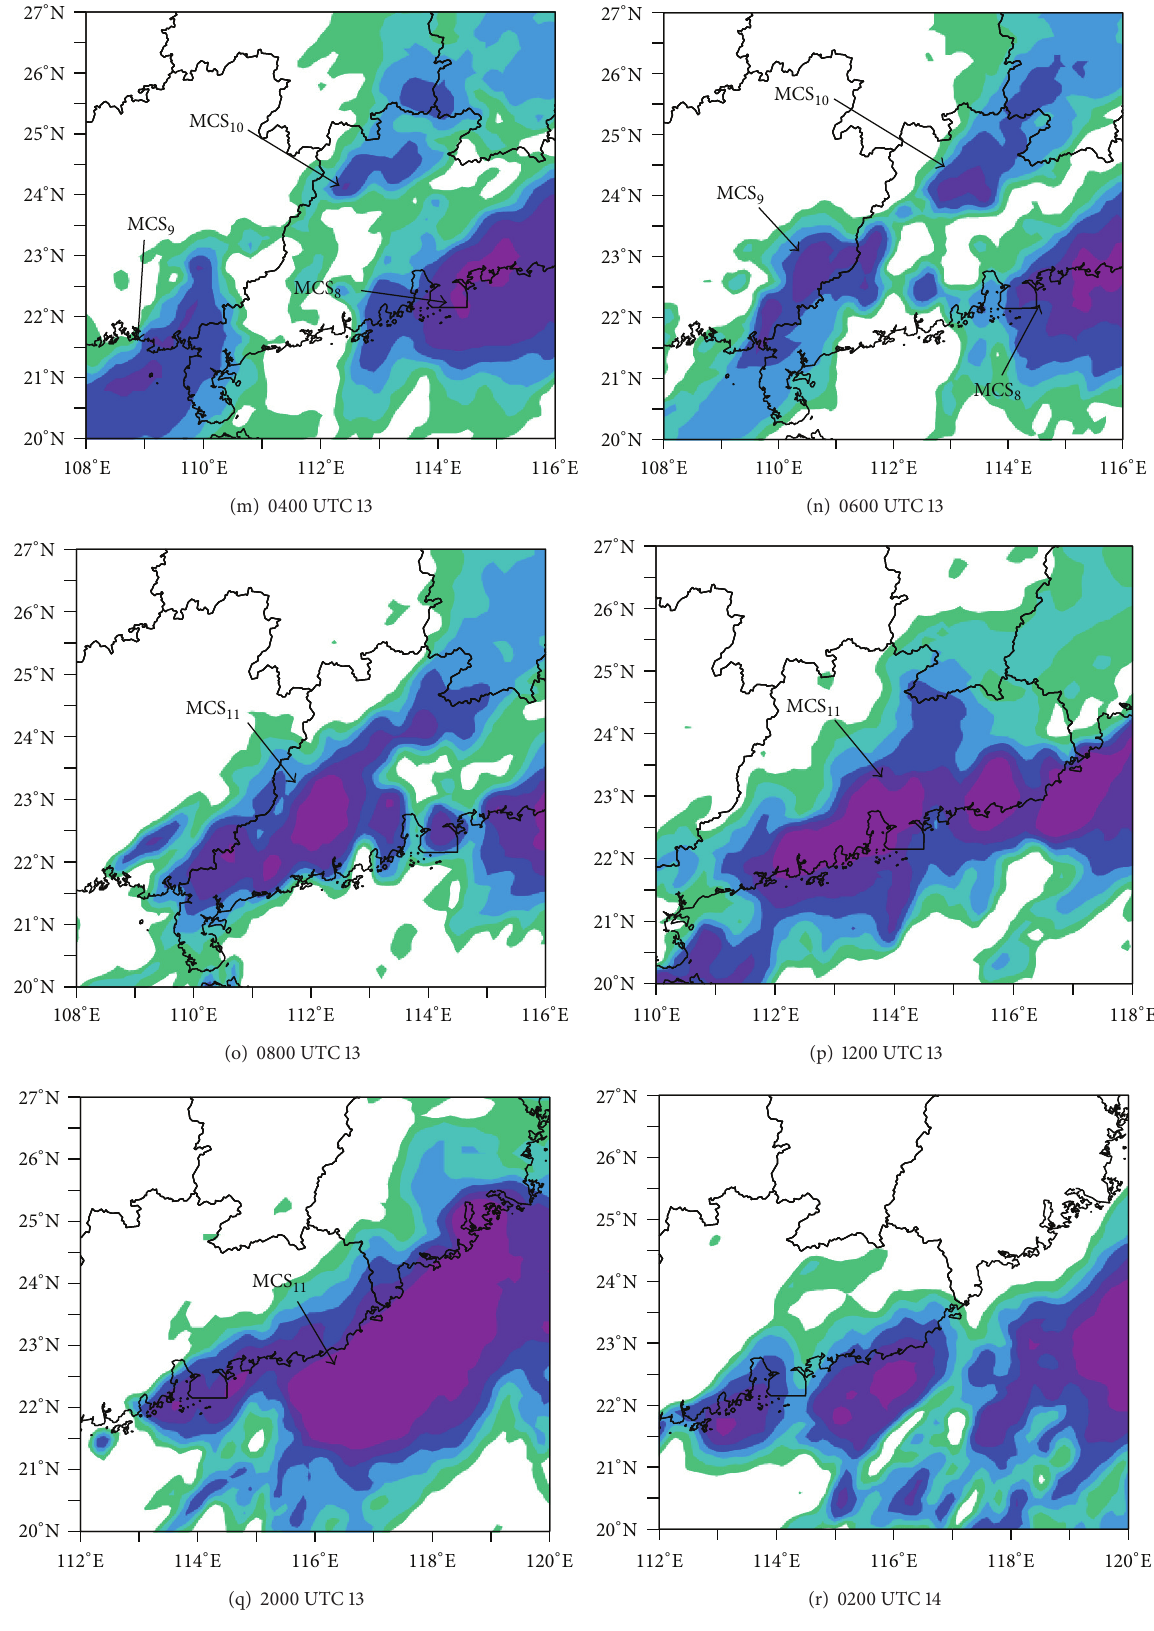
Figure 13: Horizontal distribution of TBB ( ∘ C) from June 10–14,